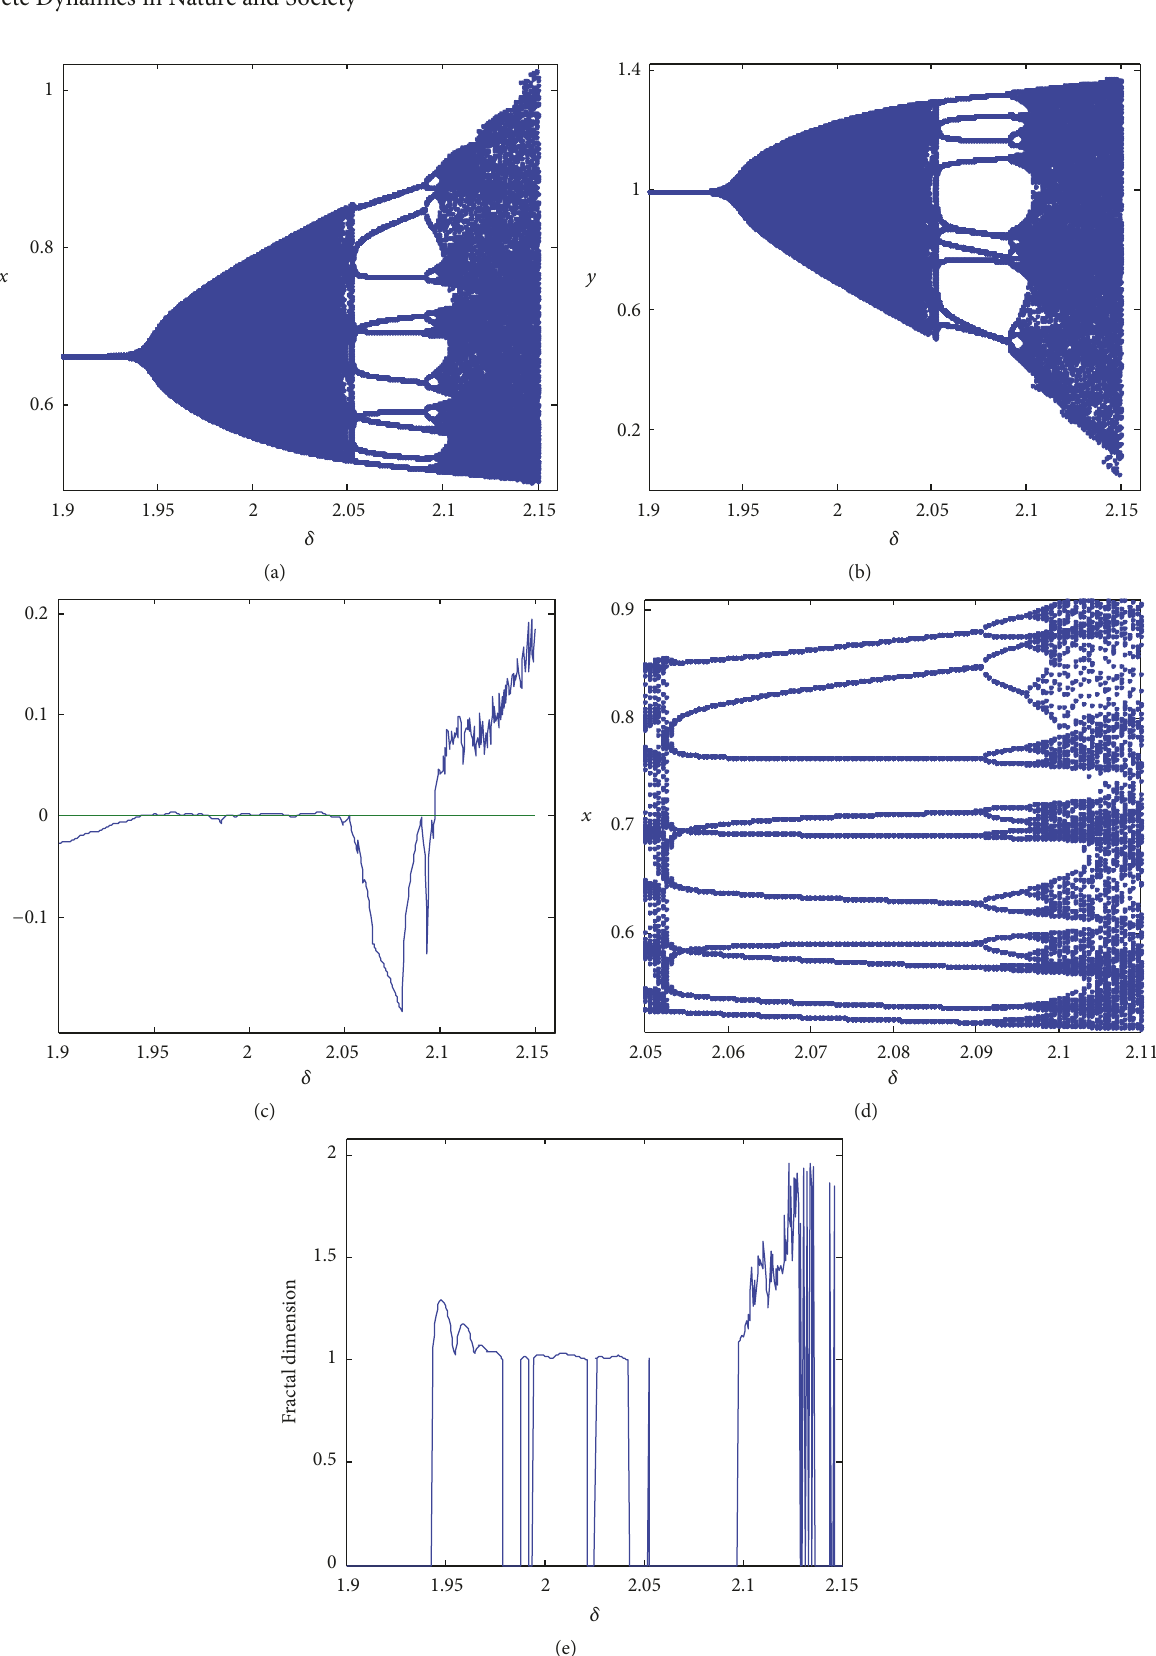
Figure 2: NS bifurcation and Lyapunov exponent of system (4) . (a) NS bifurcation for prey, (b) NS bifurcation for predator, (c) maximum Lyapunov exponents related to (a-b), (d) local amplification diagram in (a) for 𝛿 ∈ [2.05,2.11] , and (e) fractal dimension associated with (a). Initial value (𝑥 0 , 𝑦 0 ) = (0.65,0.95)